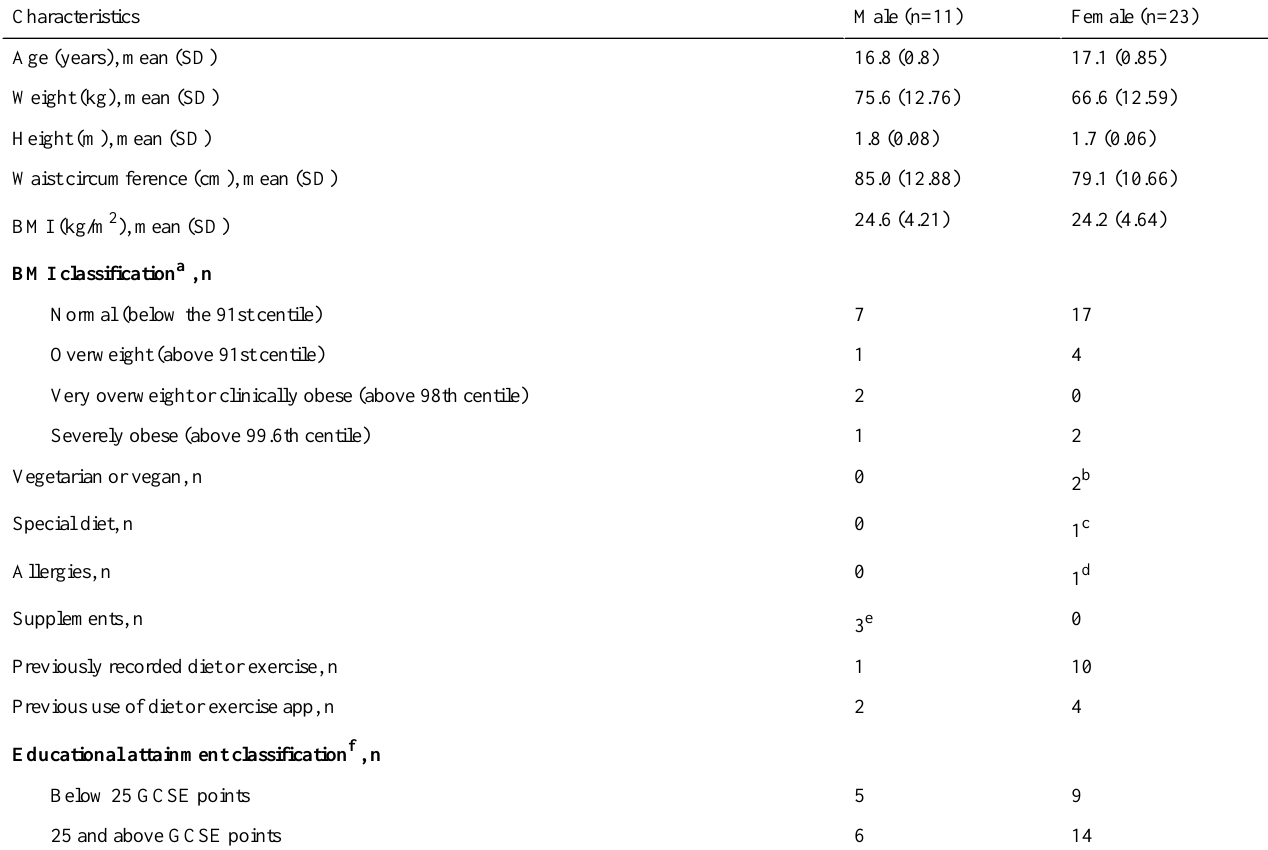
Table 1. Characteristics of participants. SD: standard deviation; BMI: body mass index; GCSE: General Certificate of Secondary Education.